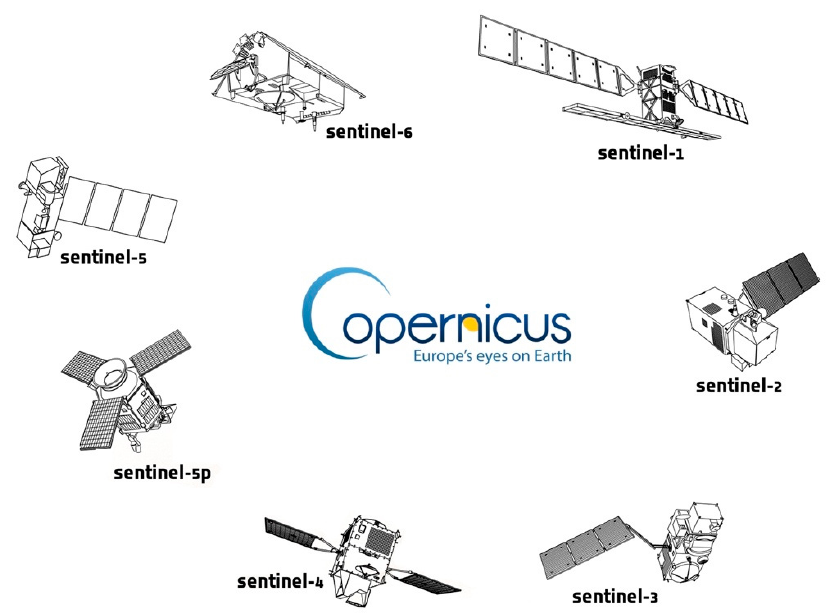
Figure 1. ESA’s operational Copernicus’s program with the Sentinel family. © ESA (modified from: [7]). We investigate here data from OLCI on Sentinel-3 (S3) for Baltic Sea applications.